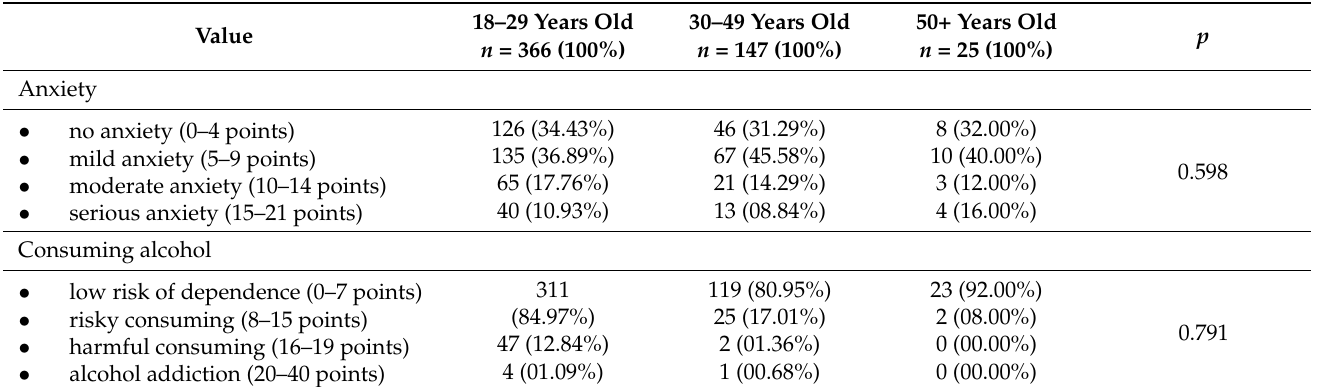
Table 5. Statistical differences between the study groups divided by age in terms of anxiety and the level of alcohol consumption after obtaining normalized